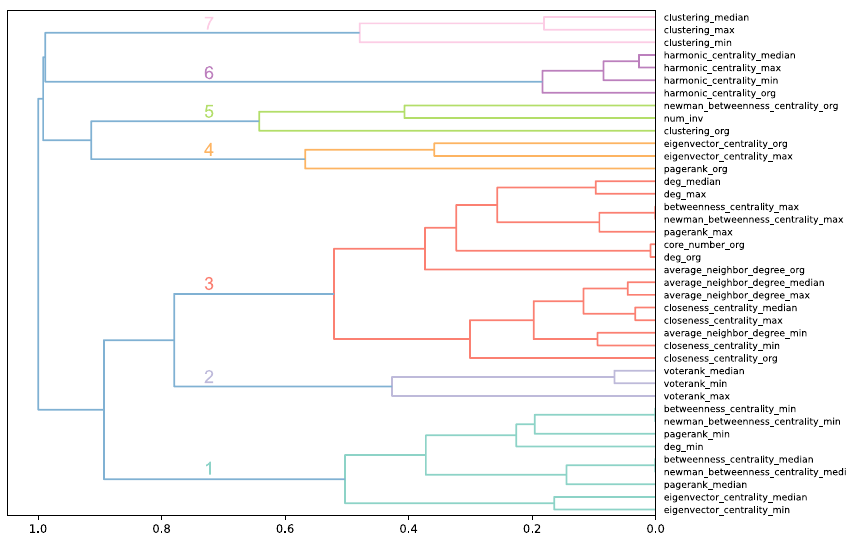
Fig. 3 Dendrogram of firms’ and investors’ centrality measures (absolute correlation distance, complete linkage). Seven groups of features are highlighted. The first from the bottom contains centrality measures for smallest and median investors; the second includes investors’ VoteRank statistics; the third contains firms’ and investors’ closeness and average neighborhood centrality, as well as measures of firms’ and big investors’ centrality; the fourth includes firms’ and big investors’ eigenvector centrality measures, as well as firms’ PageRank; the fifth contains features describing firms as knowledge bridges; the sixth includes harmonic centrality measures; the seventh includes investors’ clustering